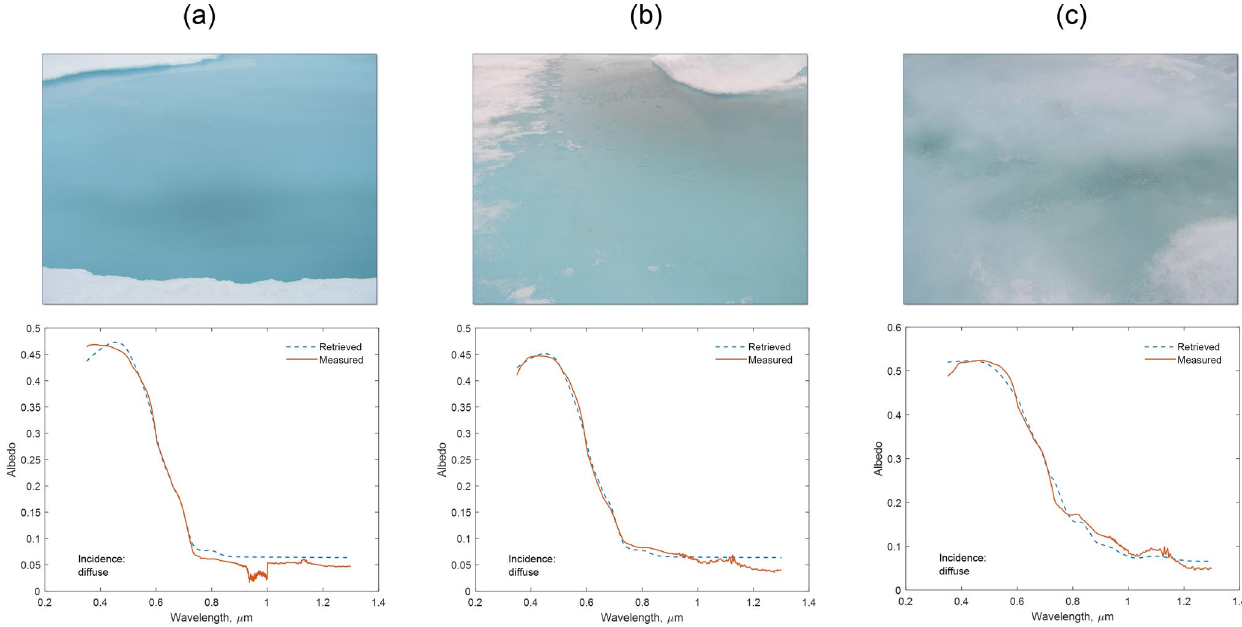
Figure 7. Frozen blue ponds. Polarstern-2012, Stations 1 (a) and 3 (b, c) . The left pond is heterogeneous. The sensor was placed approxi- mately in the center of the photograph, about 1m from the pond edge.